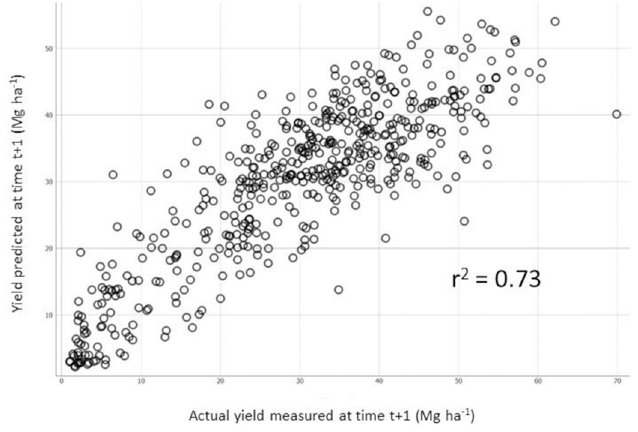
Fig 4. Relationship between actual and predicted cranberry yields at year t+1.